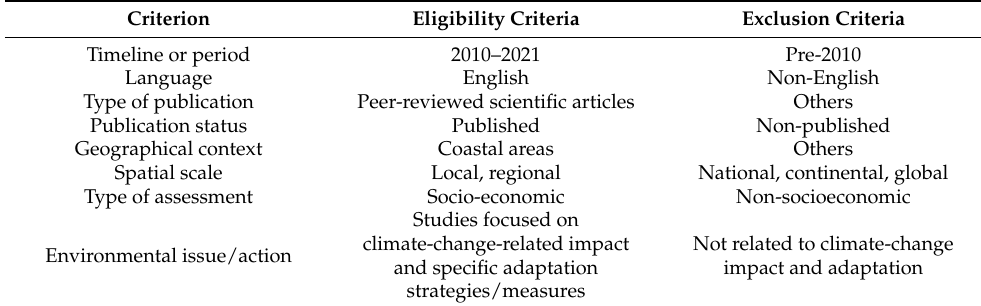
Table 1. Eligibility and exclusion criteria applied in the literature review.